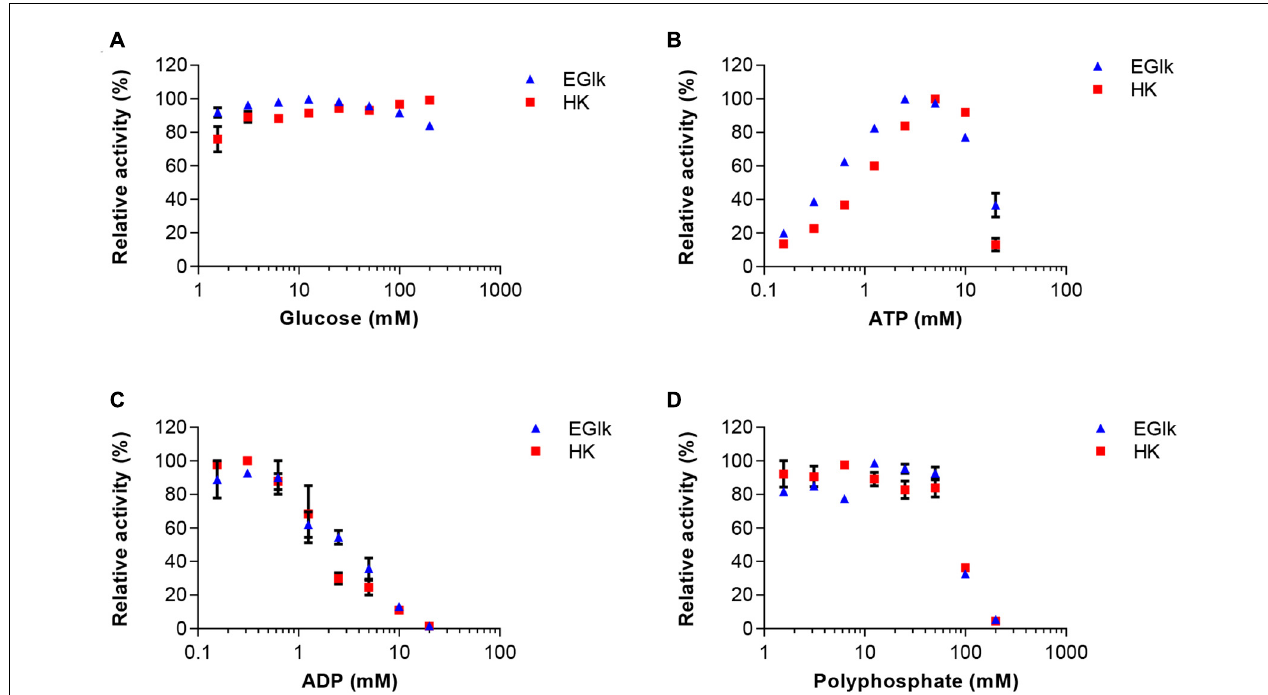
FIGURE 2 | Effect of increasing concentrations of the reaction substrates (A) glucose and (B) ATP, the reaction product (C) ADP and (D) polyphosphate on EGlk and HK activities. EGlk and HK activities were determined using a coupled enzyme assay. All data represent mean and standard error of the relative activities measured in triplicates, except for determining the effect of ADP where the results were based on duplicate experiments. Where not visible, the error bar is smaller than the symbol size.